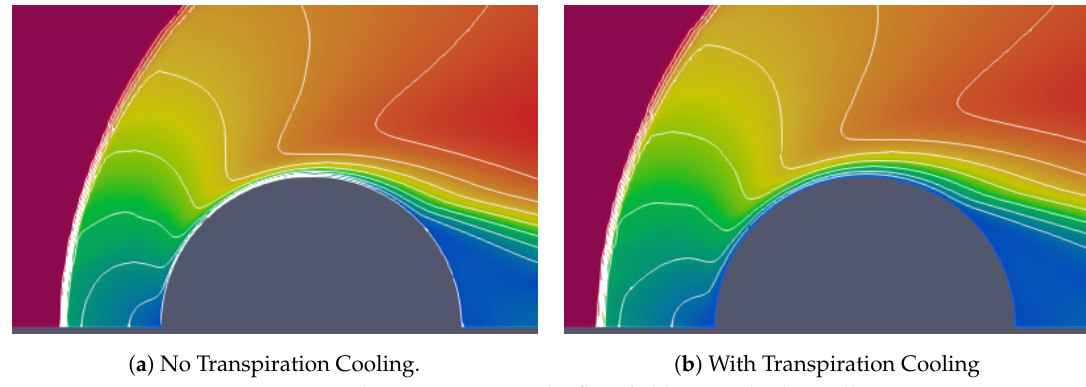
Figure 5. Velocity contours in the flow field near cylinder wall.